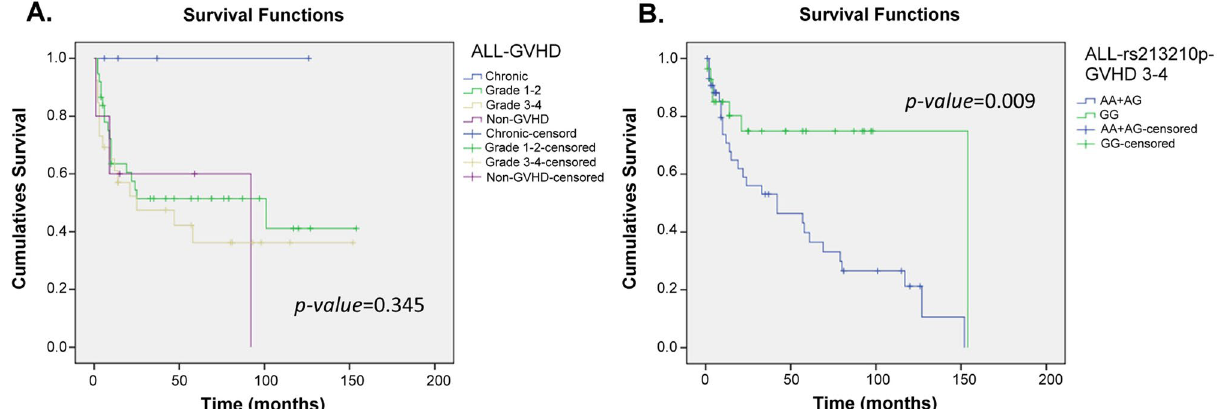
Figure 3. Kaplan–Meier analysis of overall survival curves based on the grade of GVHD and GVHD-related SNPs in ALL patients. ( A ) The survivorship curve of GVHD in ALL patients. ( B ) The rs213210 of RING1 in the recipient group. censoring: the time point of patient death or losing contact; x-axis: the time from receiving transplantation to death. y-axis: the ratio of surviving patients.